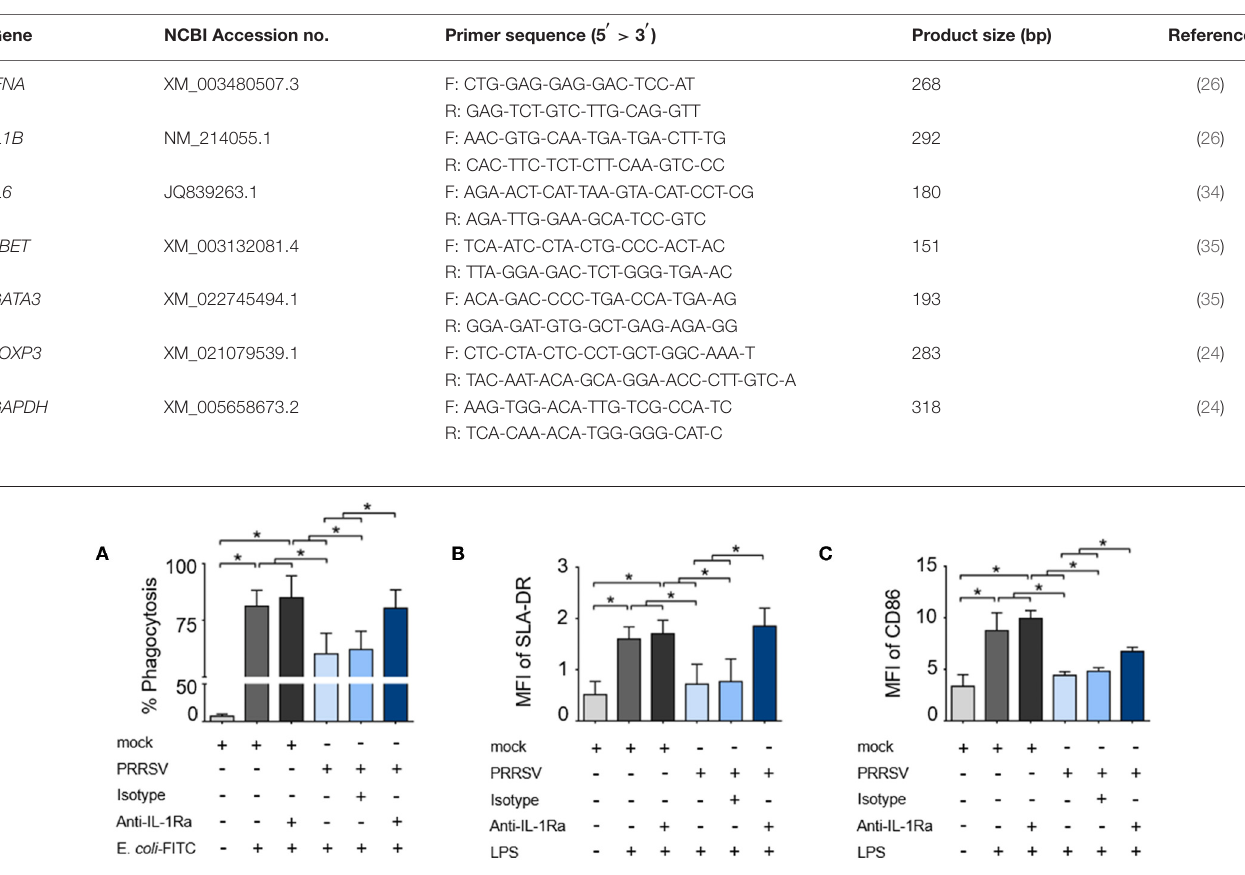
Frontiers in Immunology |